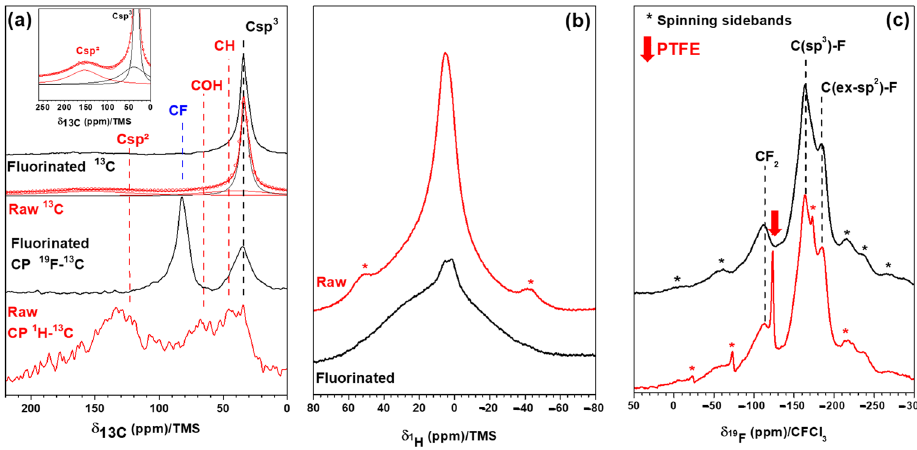
Figure 3. ( a ) 13 C MAS (10 kHz) spectra of raw and fluorinated SCD ( 1 H → 13 C and 19 F → 13 C CP were also used for raw and fluorinated samples); ( b ) 1 H MAS (14 kHz); ( c ) 19 F MAS (14 kHz) spectra. The content of H-containing groups (C-H and COH) is significantly higher in SCD than that in DND [32,43] (Figure 3b). For DND, a weak line is observed in addition